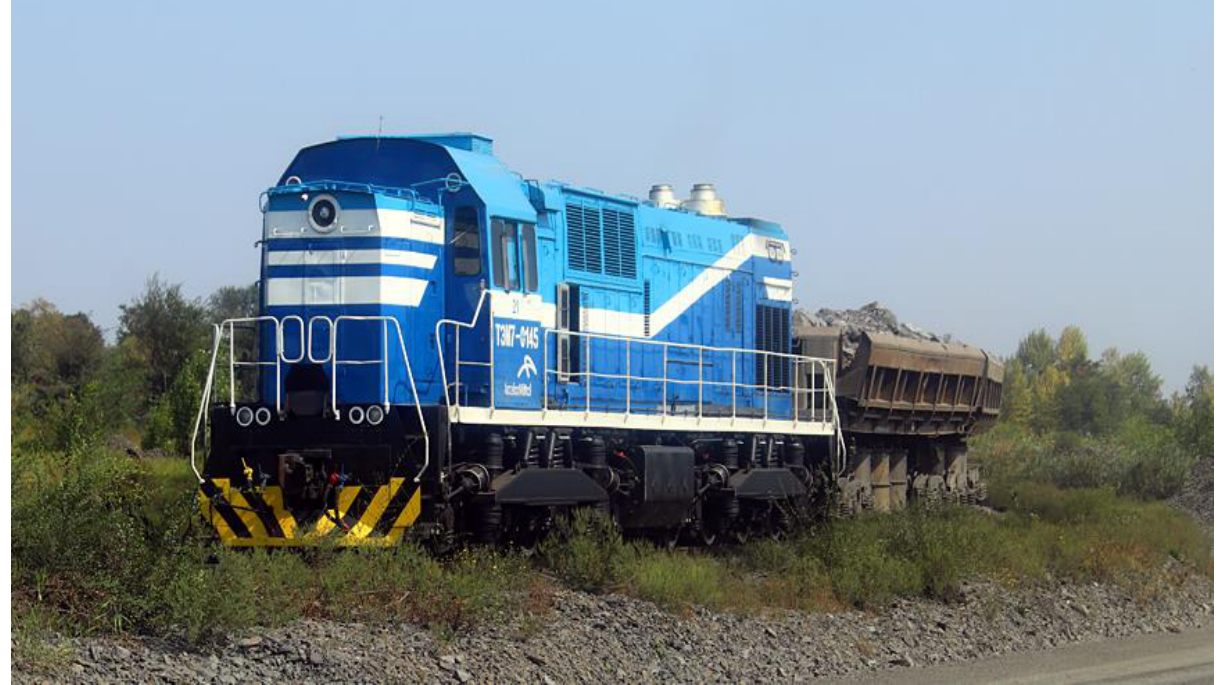
Figure 1. TEM7 locomotive after remotorization at LLC “Mykolaiv locomotive repair plant”. Source: own work.